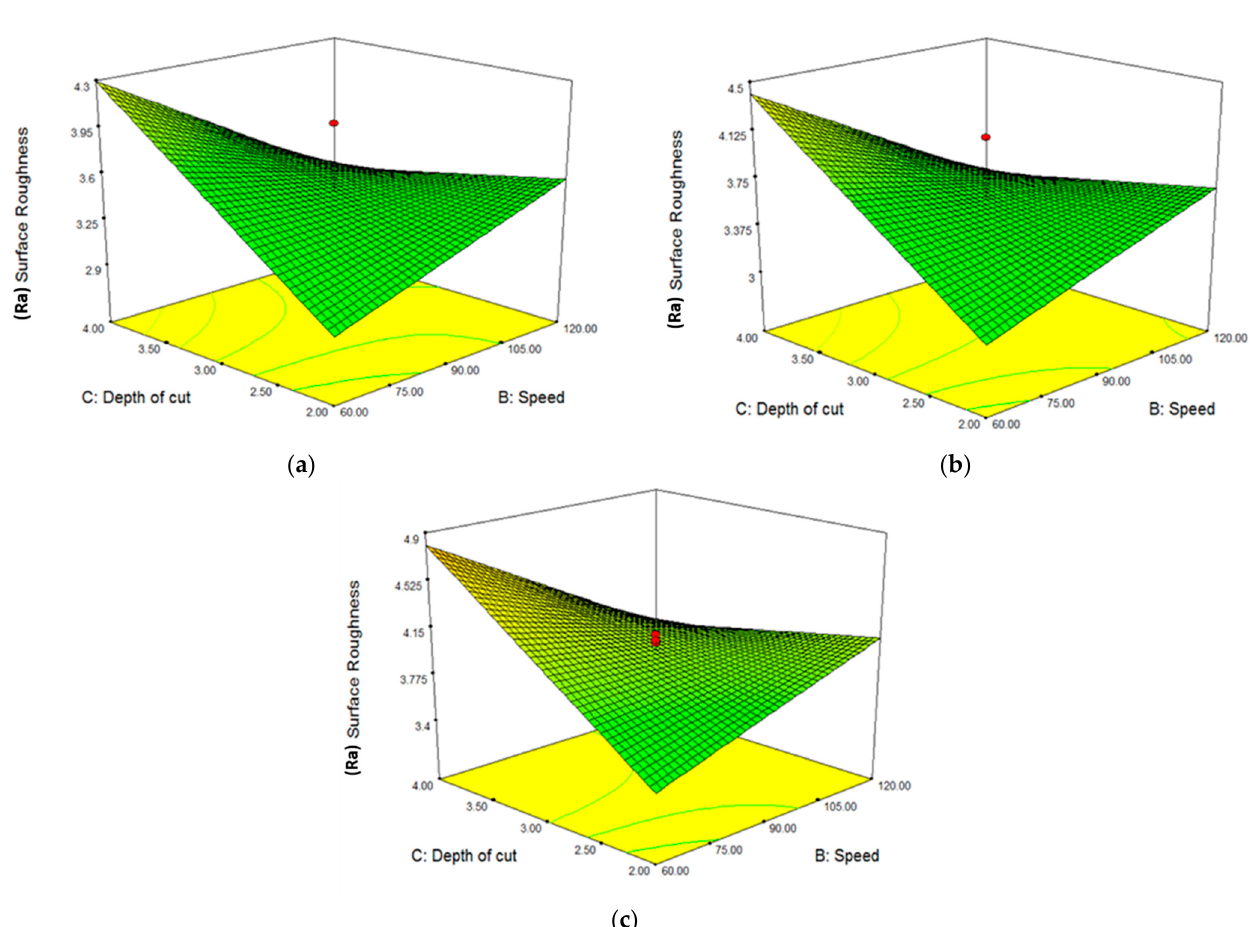
Figure 5. ( a ) 3D graph for depth of cut vs. speed (level 1), ( b ) 3D graph for depth of cut vs. speed (level 2), and ( c ) 3D graph for depth of cut vs. speed (level 3).